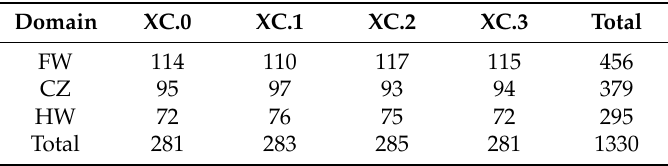
Rounded to the nearest tonne. Cross-cuts (XC) shown in Figure 2.